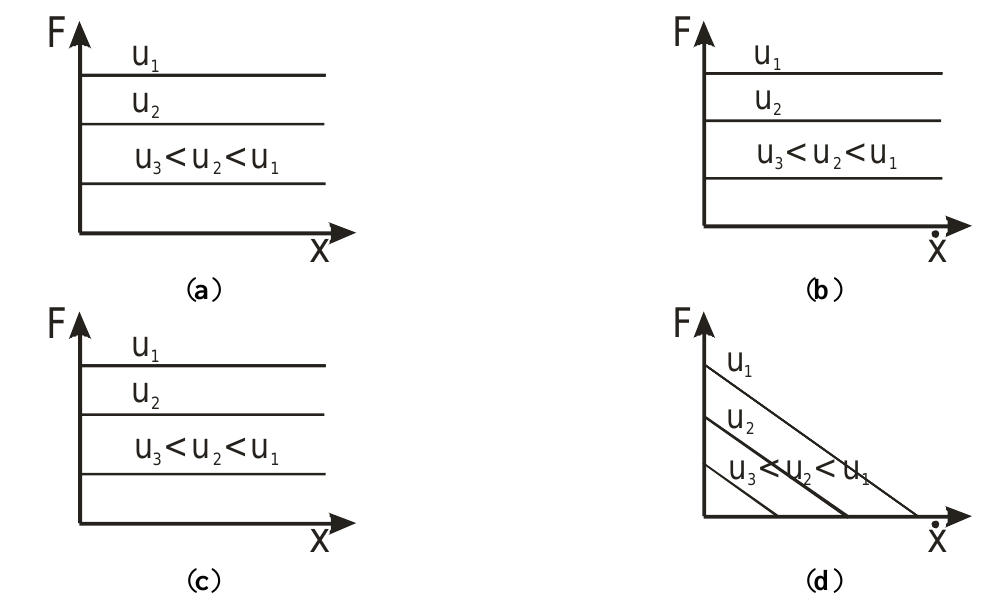
Figure 1. Typical force/position and force/velocity characteristics of an acceleration-type actuator ( a ) and ( b ) and of a velocity-type actuator ( c ) and ( d